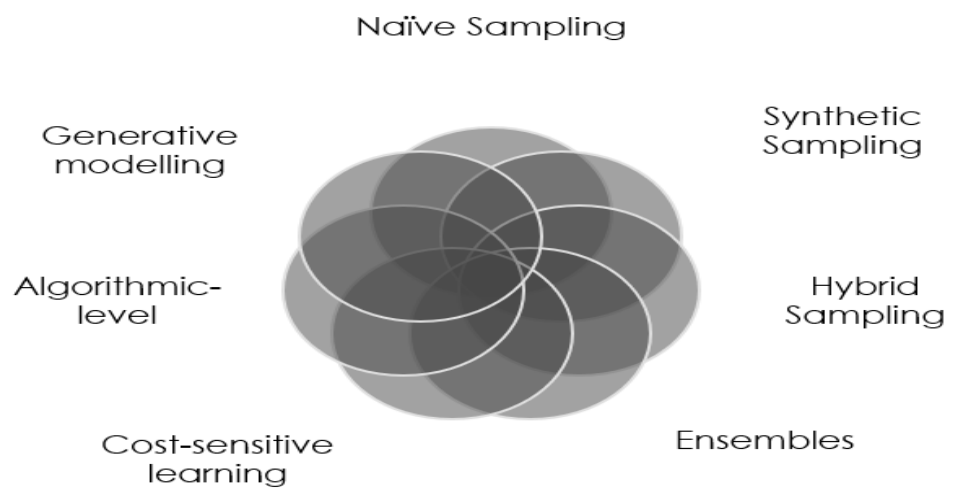
Figure 1. Taxonomy of solutions to tackle class